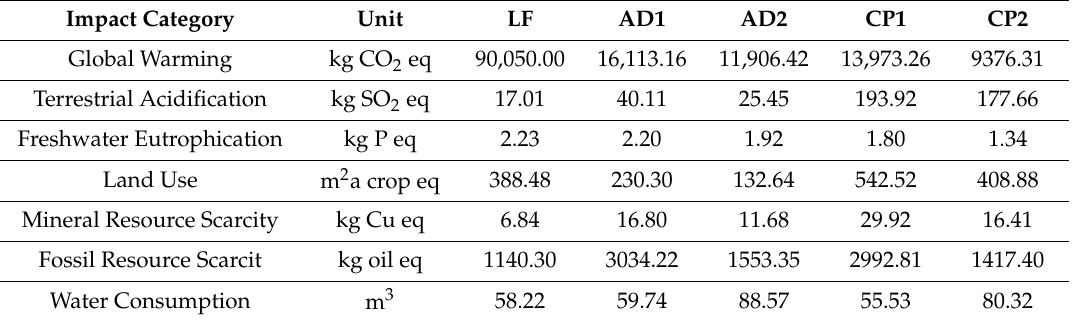
Table 4. Life Cycle Assessment (LCA) for the business as usual and alternative FW disposal or treatment